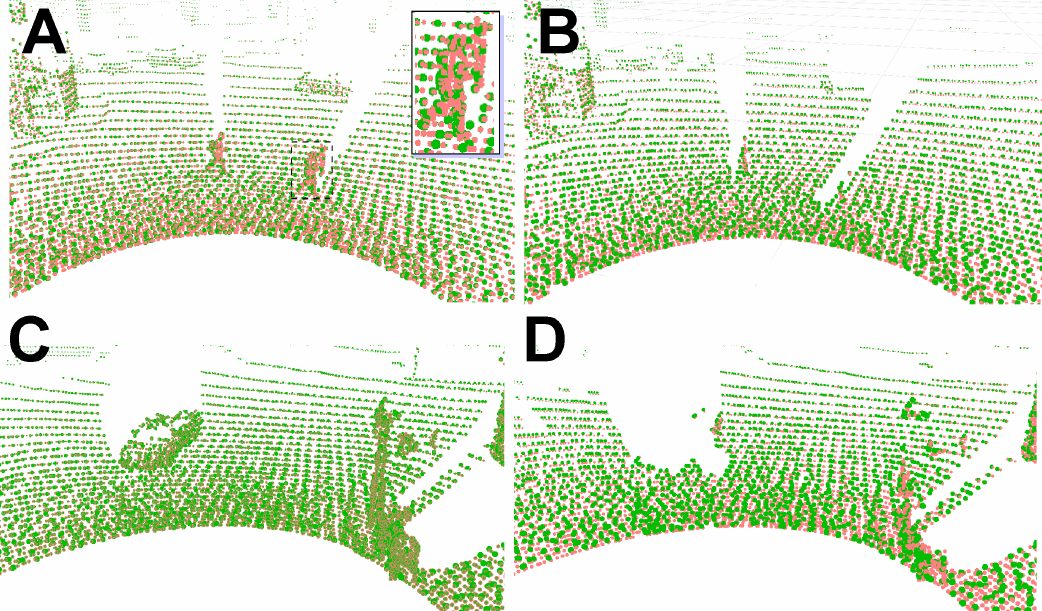
Figure 9. Point clouds before ( A , C ) and after ( B , D ) rejection of non-stationary objects. Current laser scan in orange, corre- spondences to the map points in green. Invalid correspondences are clearly visible in the enlarged fragment (inset image).